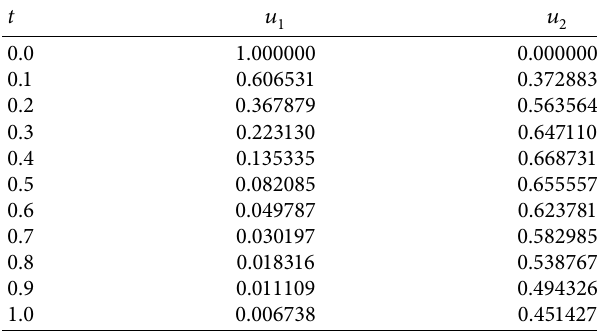
Table 1: Discrete points of the analytical solution